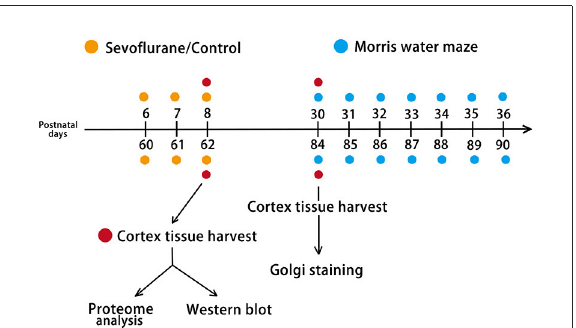
FIGURE1 Experimental design. Mice were randomly assigned to four groups: P6 + Control, P6 + Sevoflurane, P60 + Control, and P60 + Sevoflurane. P6 (female plus male) and P60 (female) mice were subjected to 60% O 2 + 3% sevoflurane or 60% O 2 inhalation for 2h over 3 consecutive days. Two hours after the last treatment, the cerebral cortex was harvested for TMT-based quantitative proteome analysis and western blotting. After 22 days of treatment, female mice were selected for the Morris water maze (MWM) test and Golgi staining. P6, postnatal day 6; P60, postnatal day 60; TMT, Tandem mass